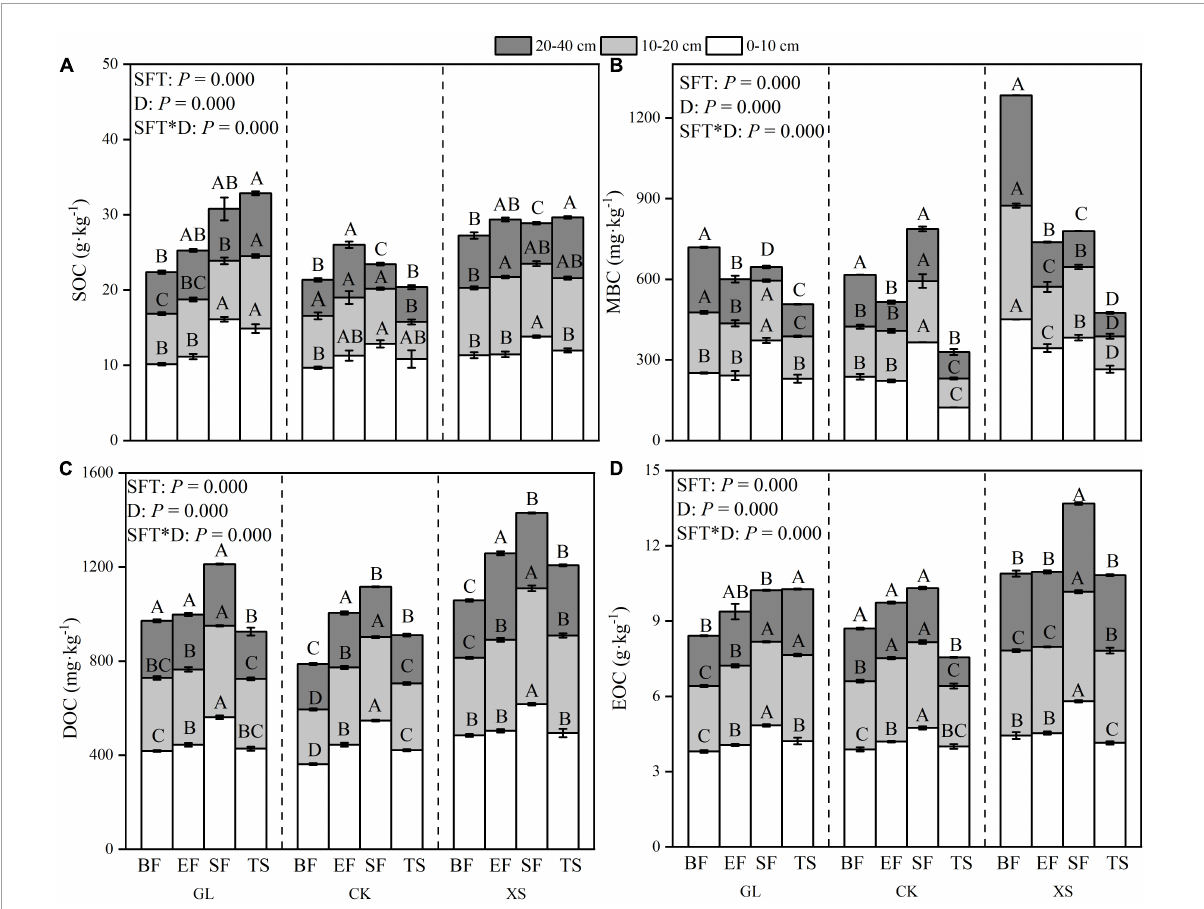
FIGURE4 Seasonal freeze-thaw (FT) dynamics of SOC [ (A) , Soil organic carbon], MBC [ (B) , Microbial biomass carbon], DOC [ (C) , Dissolved organic carbon], and EOC [ (D) , Easily oxidized organic carbon] contents in each soil layer from 0 to 40 cm under different vegetation restoration types. GL, Grassland; CK, Caragana korshinskii ; XS, Xanthoceras sorbifolia ; BF, Before freezing; EF, Early stages of freezing; SF, Stable freeze stage; TS, Thawing stage. SFT, D denote Type of Seasonal FT processes, Depth of soil layer, respectively. Error bars indicate standard error of the mean ( n = 3). According to the LSD multiple variance test, different capital letters indicate significant differences in the seasonal FT process for each indicator under the same vegetation type and soil layer ( P <